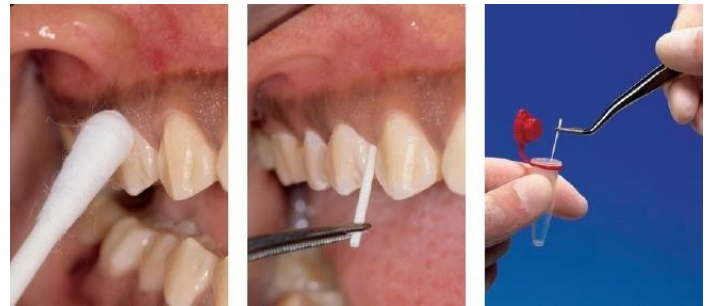
Figure 1. Protocol of gingival crevicular fluid acquisition.